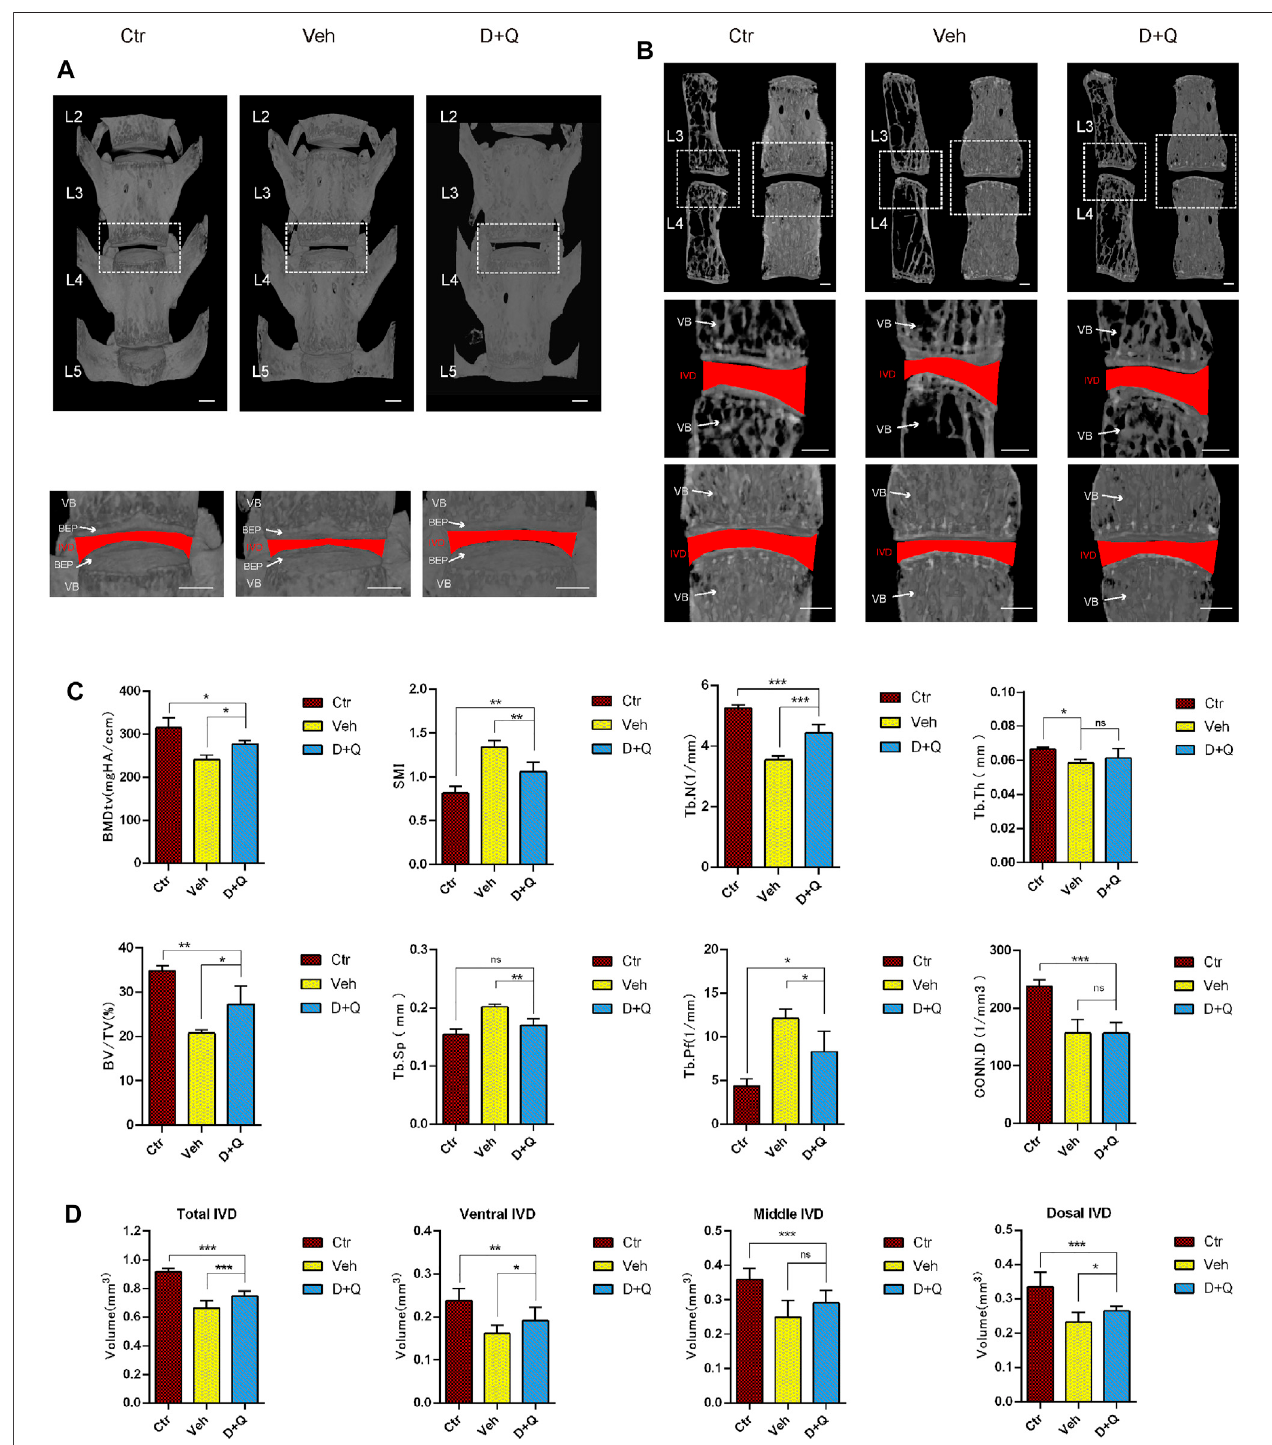
FIGURE2| ChangesinL2 – L5microarchitectureparametersoftheintervertebraldiscandvertebralbonedetermined bymicrocomputedtomography. (A) Coronal view of microcomputed tomography reconstructed image of L2 – L5 vertebrae bone. The white dotted box is zoomed in, as coronal view of the L3/4 intervertebral disc. Theredarearepresentsthediscvolume. (B) CoronalandsagittalsectionviewofL3andL4vertebraebone.Thewhitedottedboxiszoomedin,ascoronalviewoftheL3/ 4intervertebraldisc. Thered arearepresents thediscvolume. (C) Thebone morphometryparameters ofL2 – L5trabecular bone. Markedlyincreasedbone volume (BV)/total volume (TV), trabecular number (Tb.N; 1/mm), and decreased trabecular pattern factor (Tb.pf; mm), trabecular separation (Tb.Sp (mm), and structural model index (SMI)in the D+ Qgroup are shown when compared withthe control group. (D) Thequanti fi ed data ofL3/4 intervertebral disc volume. Markedly increased volume